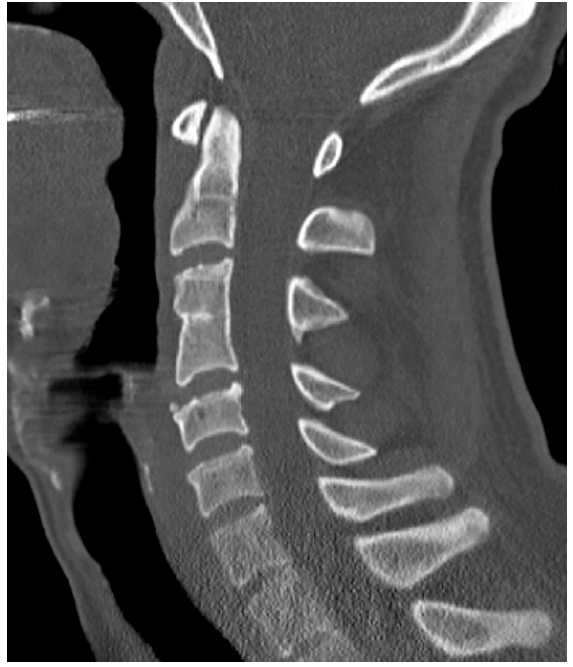
Figure 1. Sagittal CT reconstruction; 28 y/o female; congenital block vertebra C3/4 with degenerative changes in segments C4/5 and C5/6 representing a combination of ASDI and natural degenerative changes. Diagnostics 2022 , 12 , 90